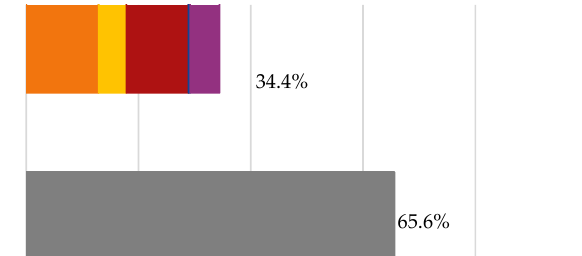
Figure 1. Number of products that made a ‘no added sugar’ claim or statement ( n = 1743) by presence of sugar-contributing ingredients (free sugars as defined in [12], fruit and vegetable purees, fruit and vegetable powders and combinations thereof).